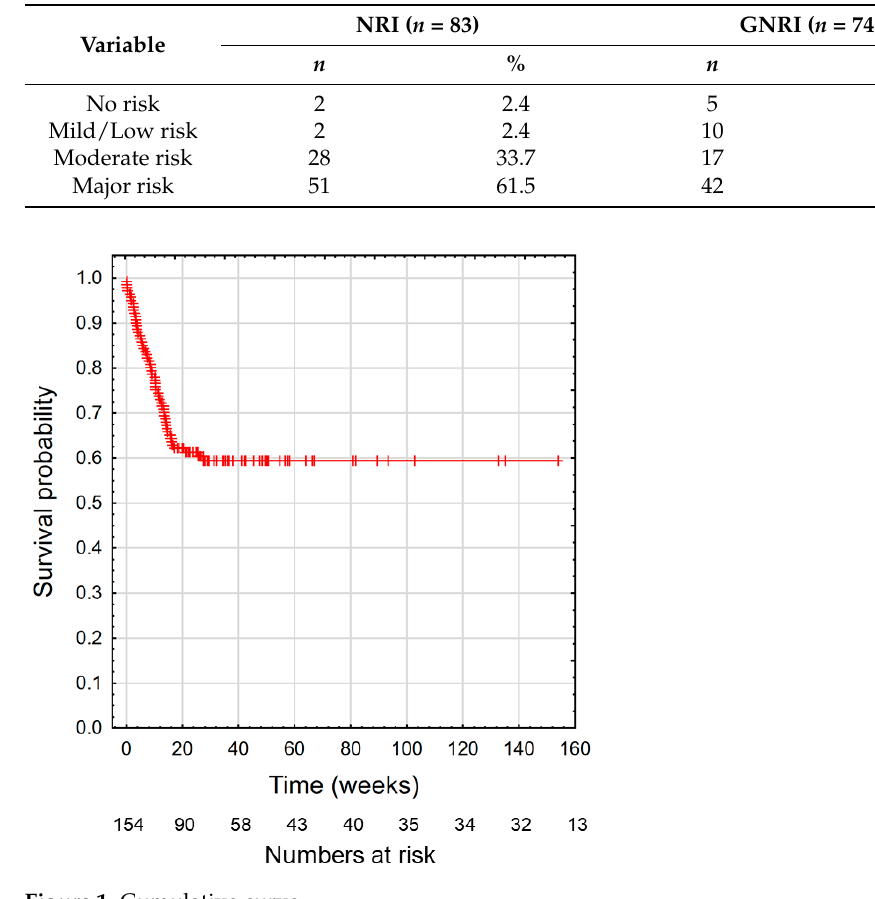
Figure 1. Cumulative curve.